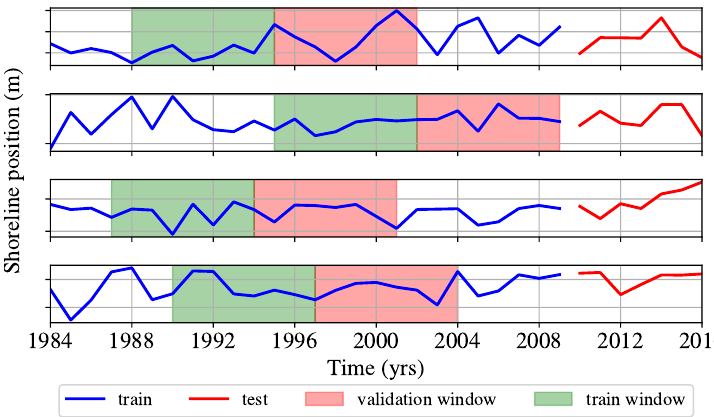
Figure 3. Schematic overview of train, validation and test partitions. The latter seven years of observations (test partition) remain hidden to the models when optimizing their parameters and are reserved for forecast accuracy assessment. Considering the ML models, train and validation windows are sampled within the train sequence. These models update their weights per batch of time-series and optimize their hyperparameters using the validation